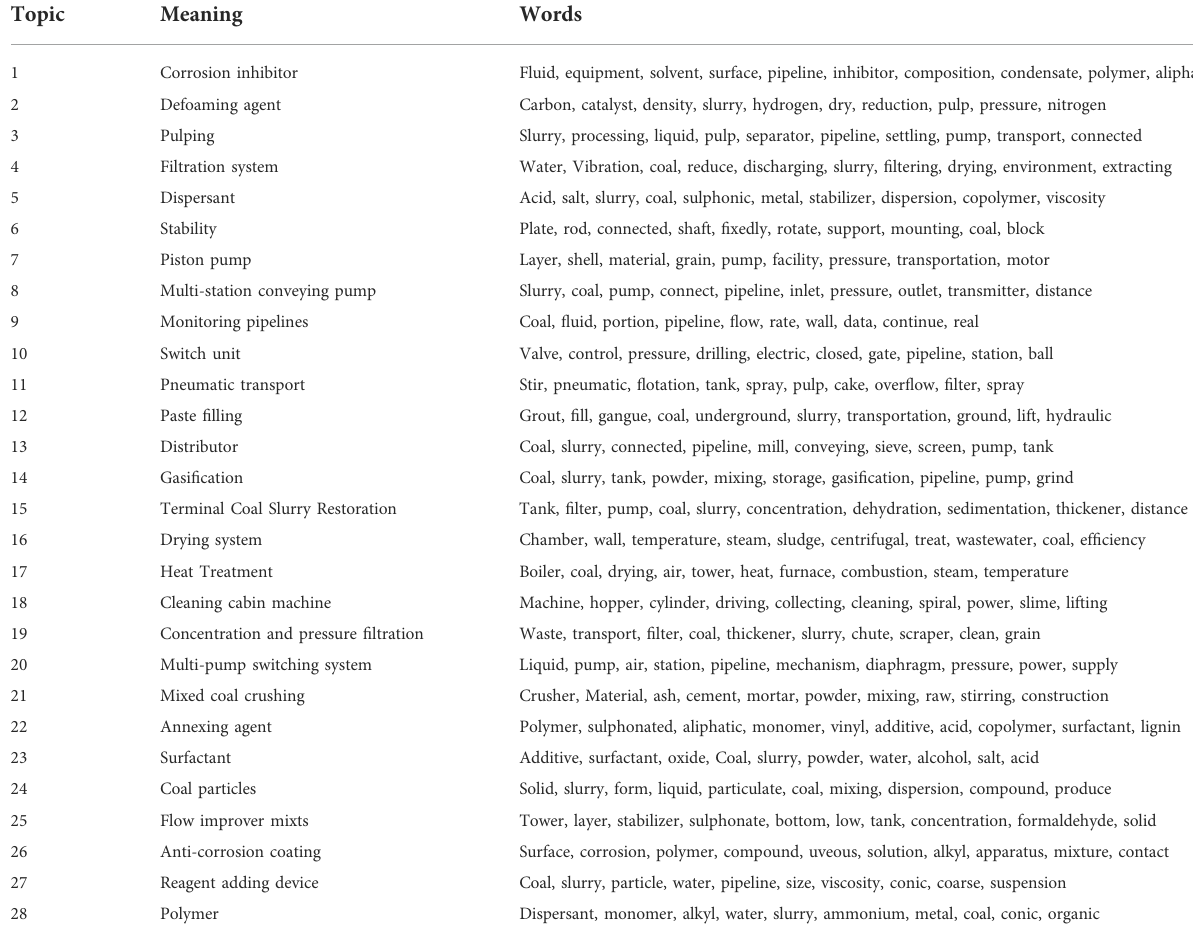
TABLE 2 The results of topic